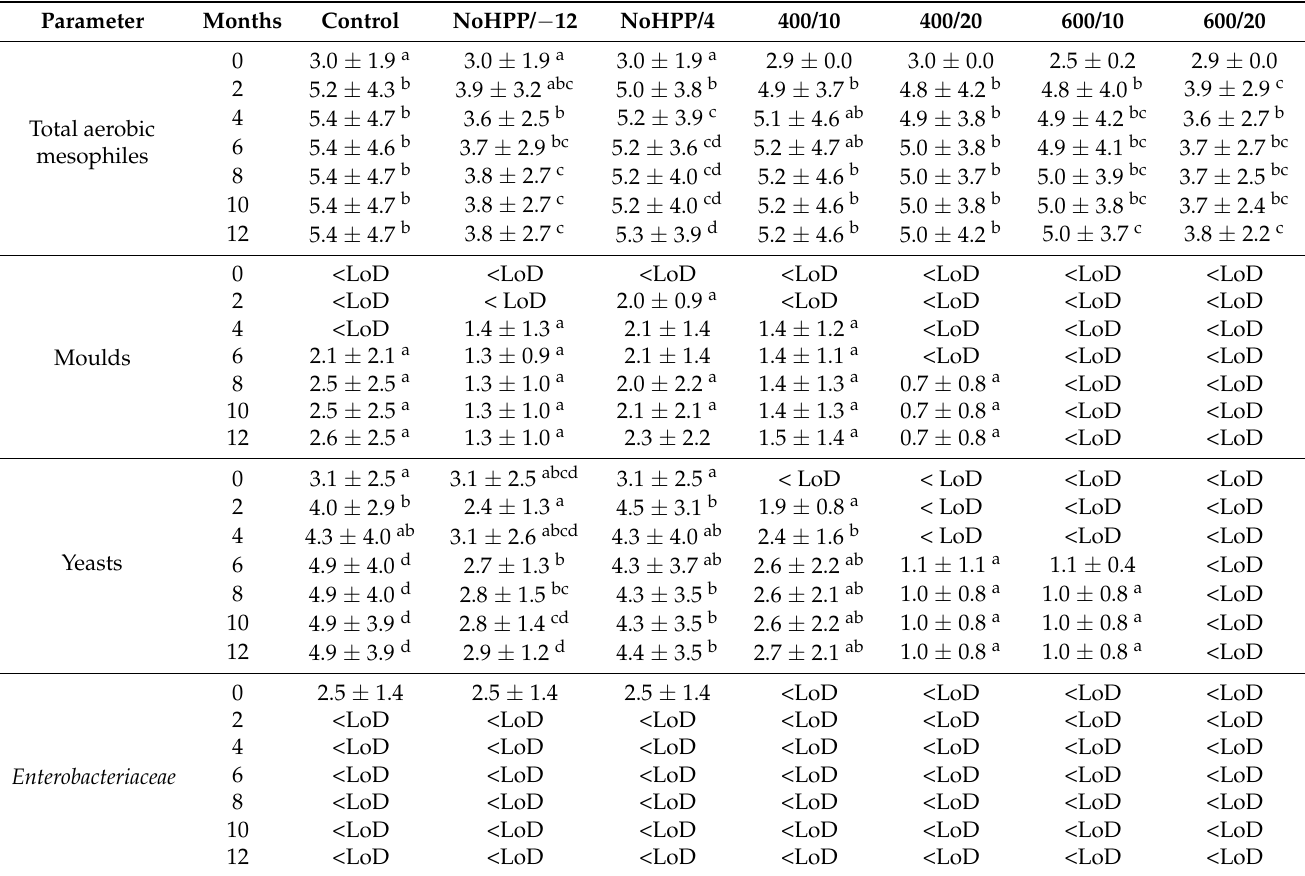
Table 3. Impact of different processing and storage conditions on the evolution of total aerobic mesophiles, moulds, yeasts and Enterobacteriaceae during storage time (log 10 cfu/g). The values are presented as mean ± standard